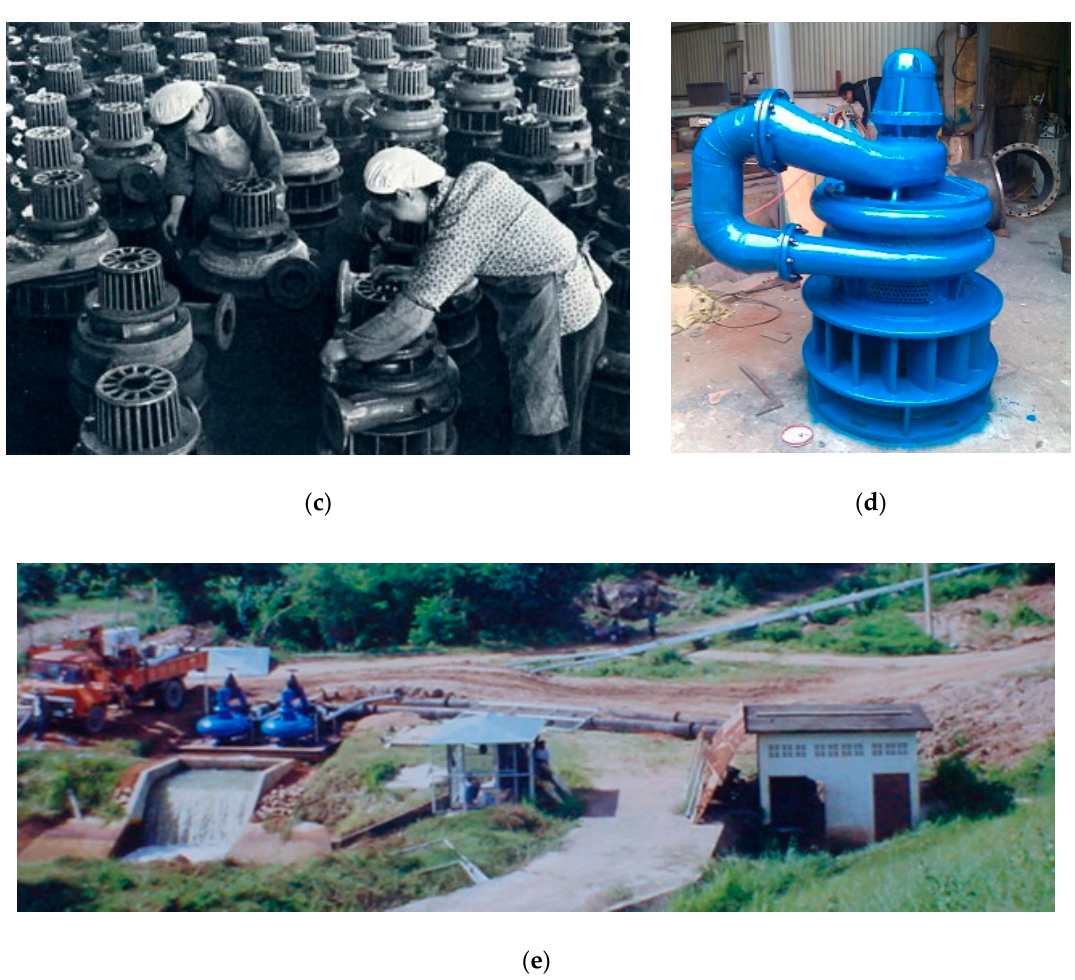
Figure 5. Di ff erent types of water turbine-pumps (WTPs): ( a ) Hydraulic converters installed in in the Mu ff atwehr at the Isar River in Munich [81]. Reproduced with permission from Springer Nature. © Springer Nature (https: // doi.org / 10.1007 / 978-3-642-50802-8_18); ( b ) Schematic view of the typical installation of a WTP [14]. Reproduced with permission from Food and Agriculture Organization of the United Nations © FAO (http: // www.fao.org / 3 / ah810e / AH810E12.htm#12.1). A from the original; ( c ) Mass production of Chinese water turbine-pump (CWTP). Reproduced with permission from Gejing Jiang. © 有 金 华 天 阳 电 子 有 限 公 司 (http: // www.jiaxiangwang.com / cn / guizhou.htm); ( d ) Multi-stage Vietnamese hydraulic pump [116]. © Vi ệ n Khoa h ọ c Th ủ y l ợ i Vi ệ t Nam (http: // www.vawr.org.vn / index. aspx?aac = CLICK&aid = ARTICLE_DETAIL&ari = 2314&lang = 1&menu = &mid = -138&pid = 1&title = cong-nghe-bom-thuy-luan-bom-nuoc-tu-dong-phuc-vu-nong-nghiep-mien-nui-va-trung-du); ( e ) Globe case coaxial water turbine pumps commissioned in the Mae Phum Reservoir, Phayao province, Thailand [117]. © Royal Irrigation Department. CC BY-NC-SA 3.0. Cropped from the original.